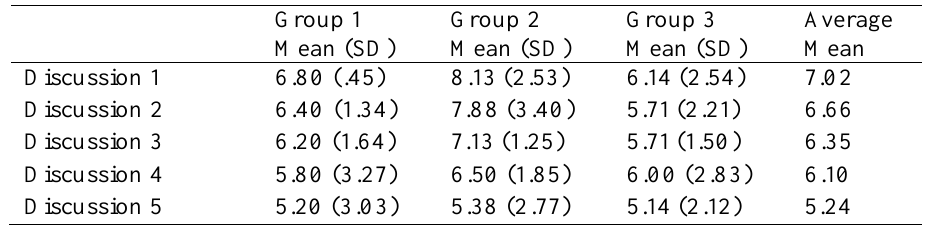
Means and Standard Deviations of the Numbers of Posted Messages per Person across Five